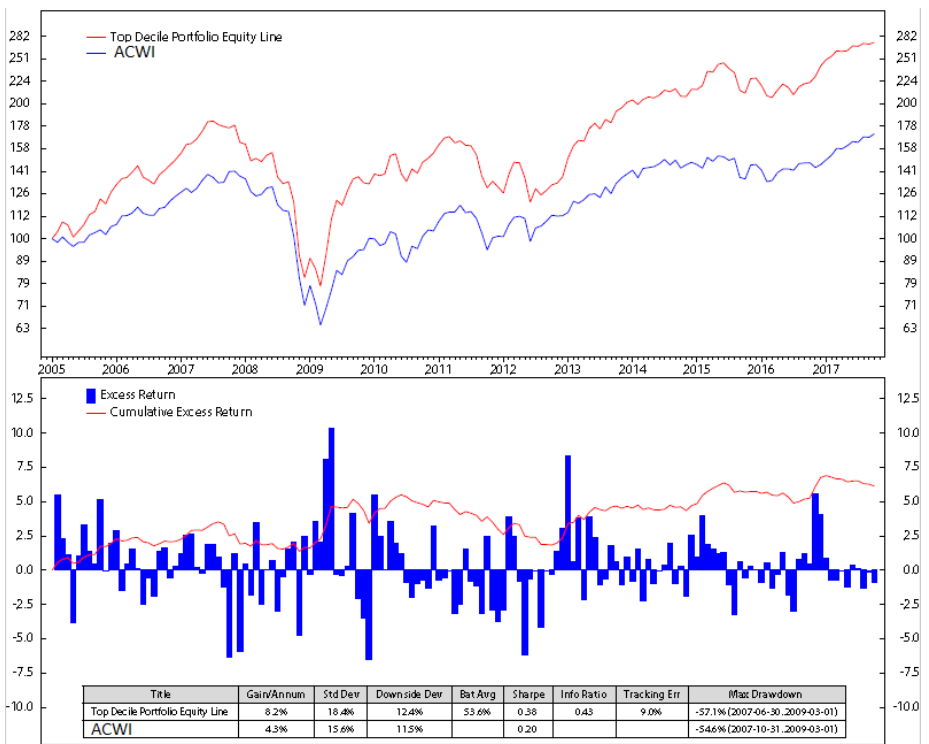
Figure A8. Global stock selection from January 2005 to September 2017 based on stock sales/ enterprise